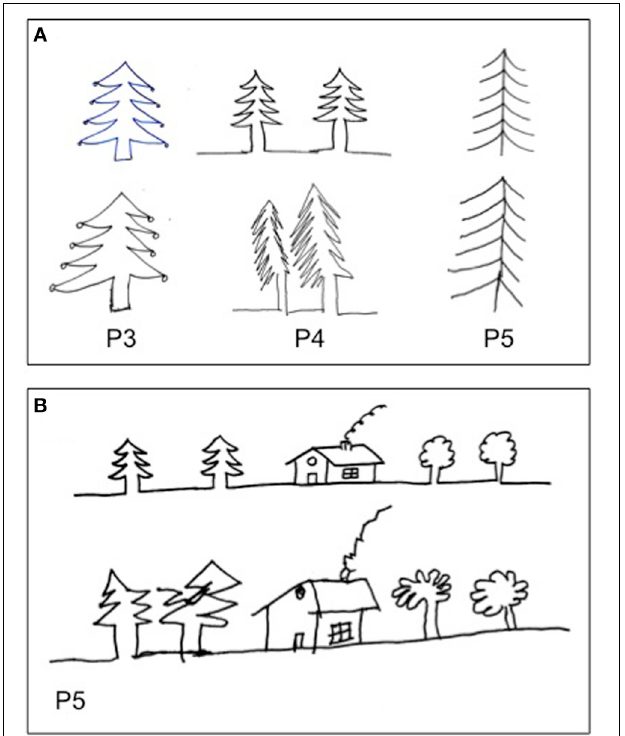
FIGURE 5 | Examples of drawing by copy (A, P#3, P#4, and P#5: fire tree), (B, P#5: house and trees (Gainotti et al., 1972). The patients drew greater left-hand side of objects, even when objects were located to the right side of model (B)